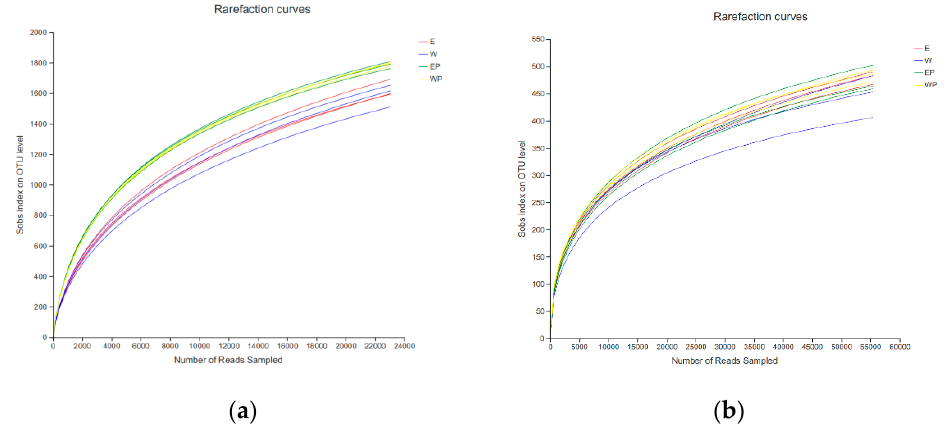
Figure 3. The rarefaction curve. ( a ) Bacteria, ( b ) fungi, E: grapevine replant soil irrigated with peanut root exudates, W: grapevine replant soil irrigated with distilled water. EP: rhizosphere soil of grapevine seedling irrigated with peanut root exudates for 28 d + 24 d; WP: rhizosphere soil of grapevine seedling irrigated with distilled water for 28d+24d.